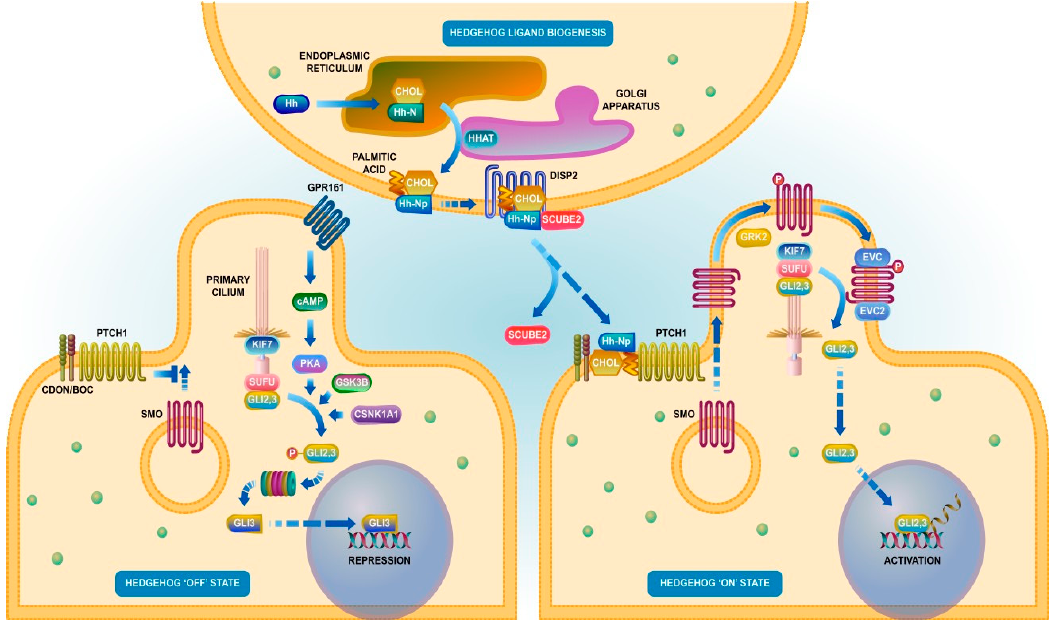
Figure 3. Schematic of biogenesis and of the “off”— “on” Hedgehog signaling. Reproduced with permission from Reactome (https://reactome.org/PathwayBrowser/#/R-HSA-5358351).